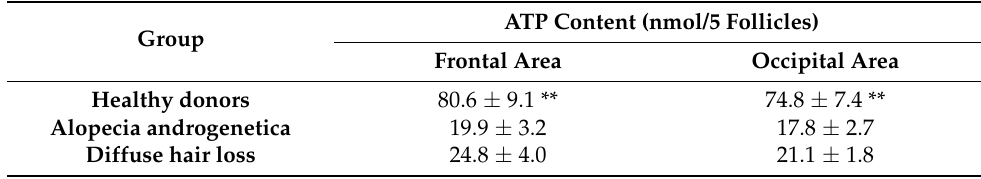
Table 3. Energy stores in hair roots/follicles taken from the frontal and occipital areas of healthy donors and patients with different types of alopecia (ATP content, nmol/5 follicles).